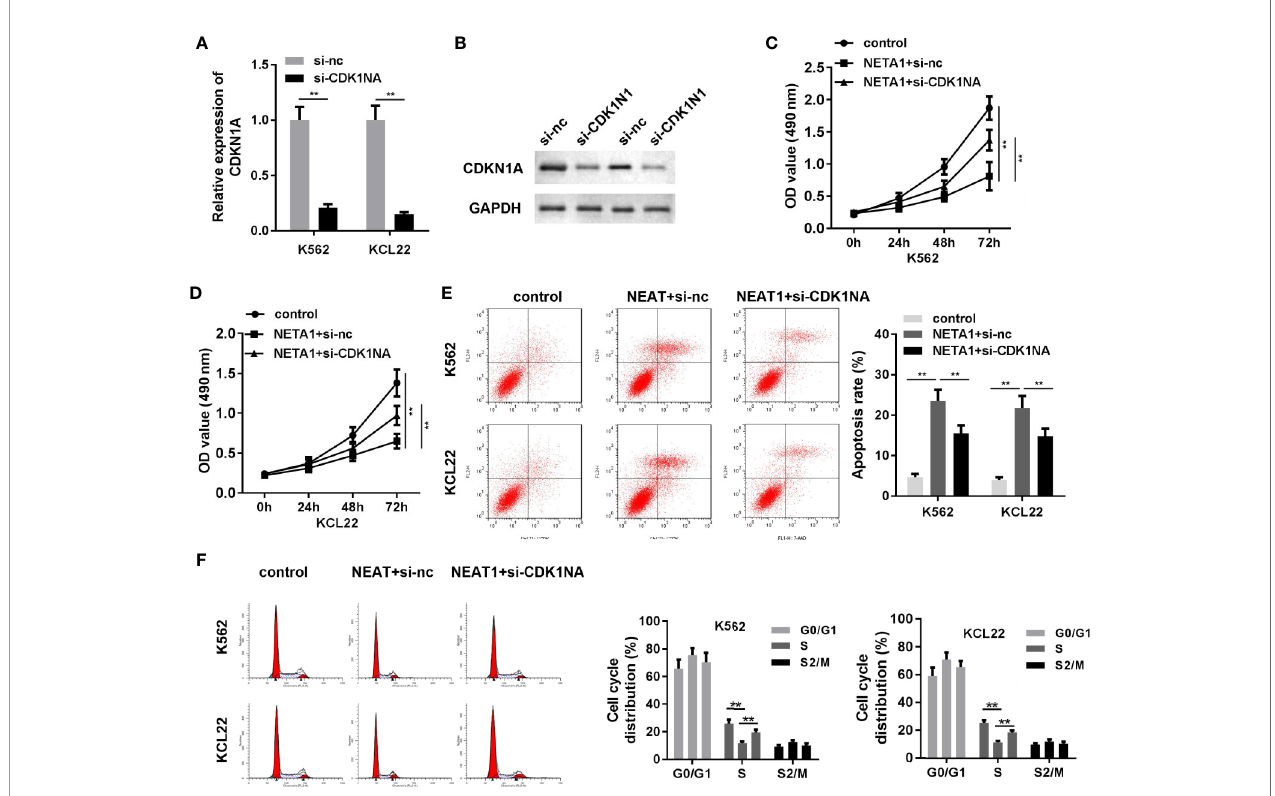
FIGURE 6 | Knockdown of CDKN1A partially abrogates the effects of NEAT1 on cell viability and apoptosis. (A, B) The transfection ef fi ciency of CDKN1A was evaluated by qPCR and western blot analysis. (C, D) The cell viability and (E) cell apoptosis of CML cells. (F) The cell cycle was evaluated by PI staining and fl ow cytometry. **P < 0.01 vs. si-NC, control or NEAT1 + si-NC. NEAT1, lncRNA nuclear enriched abundant transcript 1; NC, negative control; CML, chronic myeloid leukemia; CDKN1A, cyclin-dependent kinase inhibitors